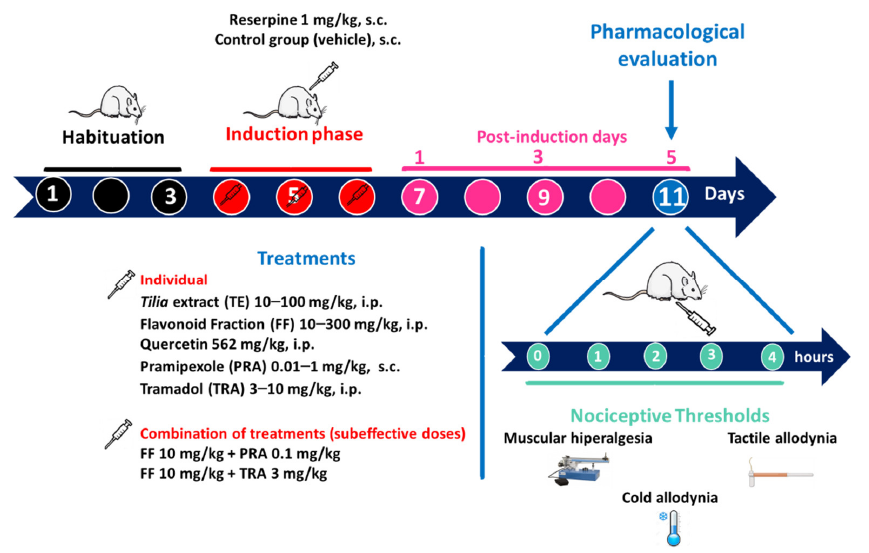
Figure 1. Timeline of the experimental design of Tilia fraction administration alone and in combina- tion with pramipexole (PRA) and tramadol